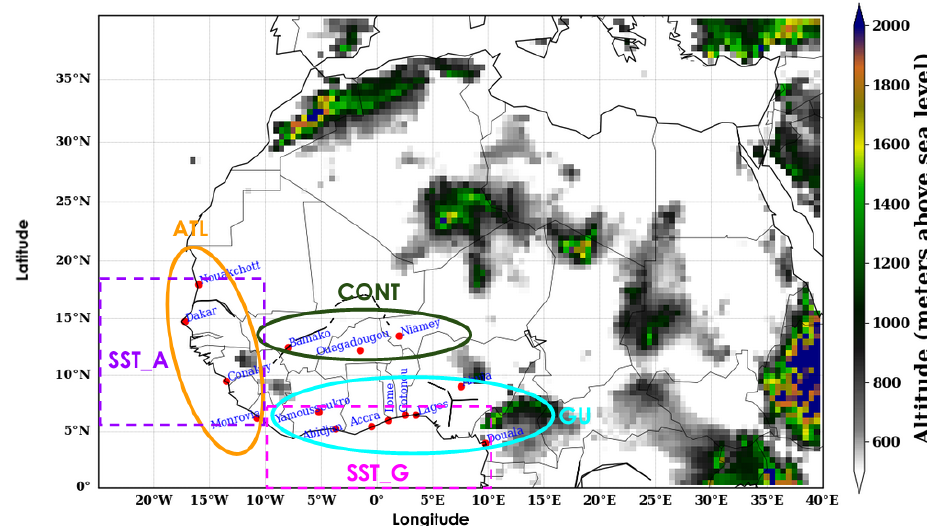
Figure 1. Topographic map of West Africa using ERA5 elevation data. The circles on the map represent the different climatic zones: ATL (coastal Atlantic zone), CONT (continental zone) and GU (coastal Guinean zone). The two boxes named SST_A and SST_G represent the boxes used to analyse the links between sea surface temperature (SST) and heat waves for the ATL and GU regions respectively. The y and x axes represent the latitude and longitude respectively. The colour bar shows the elevation in metres over the